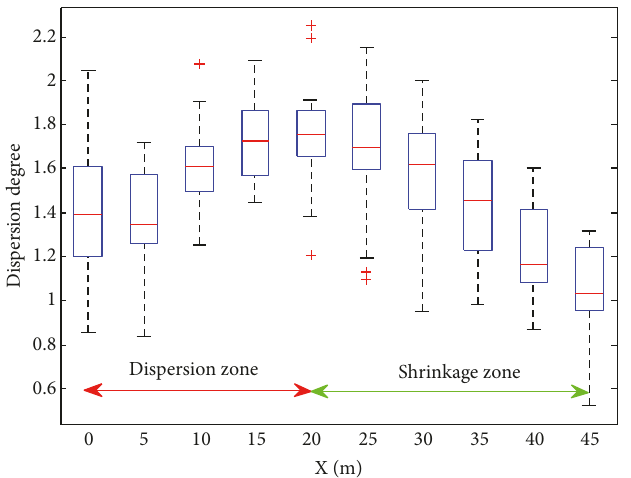
Figure 10: Boxplot of sectional dispersion degree at Xianxia-Jianhe